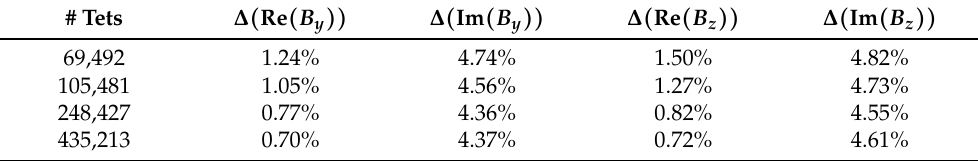
Table 12. Discrepancy between 3D CM–BEM with R-SVD compression and second order 3D FEM. #